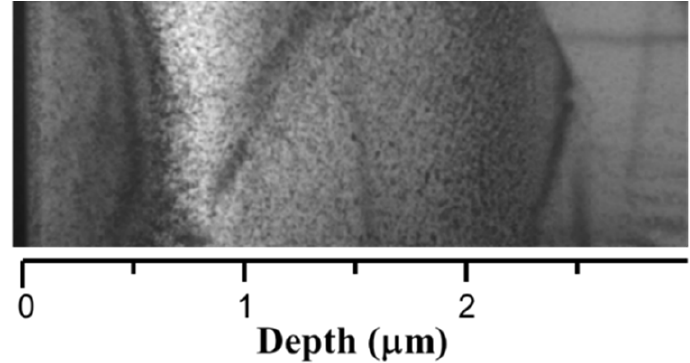
Figure 2. Cross-sectional image of SUS316L irradiated with 22.5 dpa. 3. Results